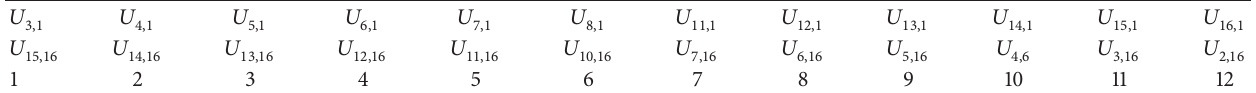
Table 2: SBVPs from electrode pair (1, 2) and electrode pair (1, 16).